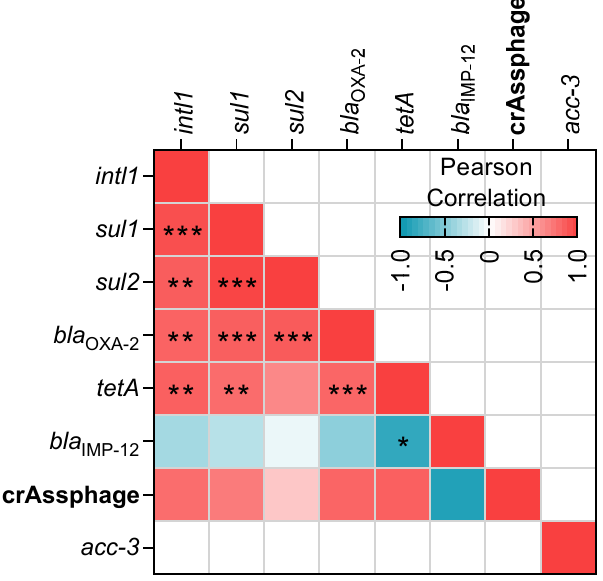
Figure 5. Correlation among the detected genes. R correlation coefficient is represented as a heat map of colors. Significative correlations are depicted as follows: * p < 0.05, ** p < 0.01, *** p < 0.001.